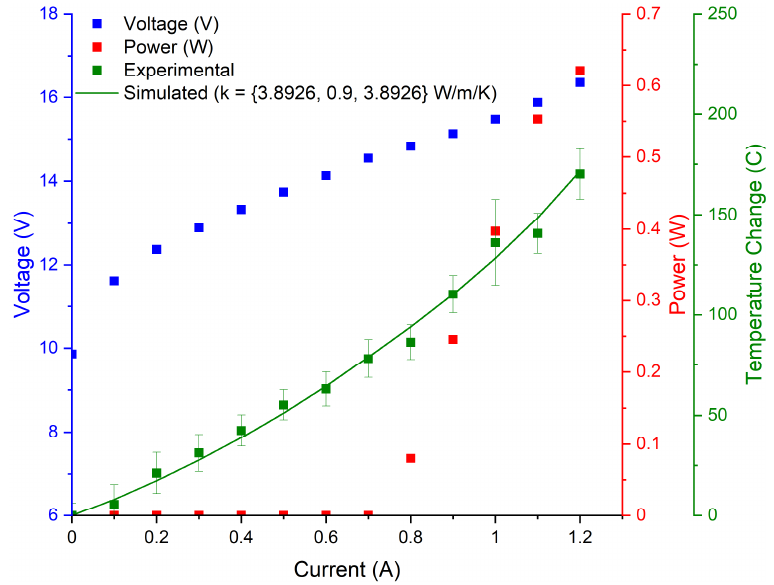
Figure 4. Temperature curves for S25 device emitting at 3.7 μ m. Cross-plane thermal conductivity is reported as 0.9 W/(m·K). Device dimensions are 5 mm × 7.2 μ m.